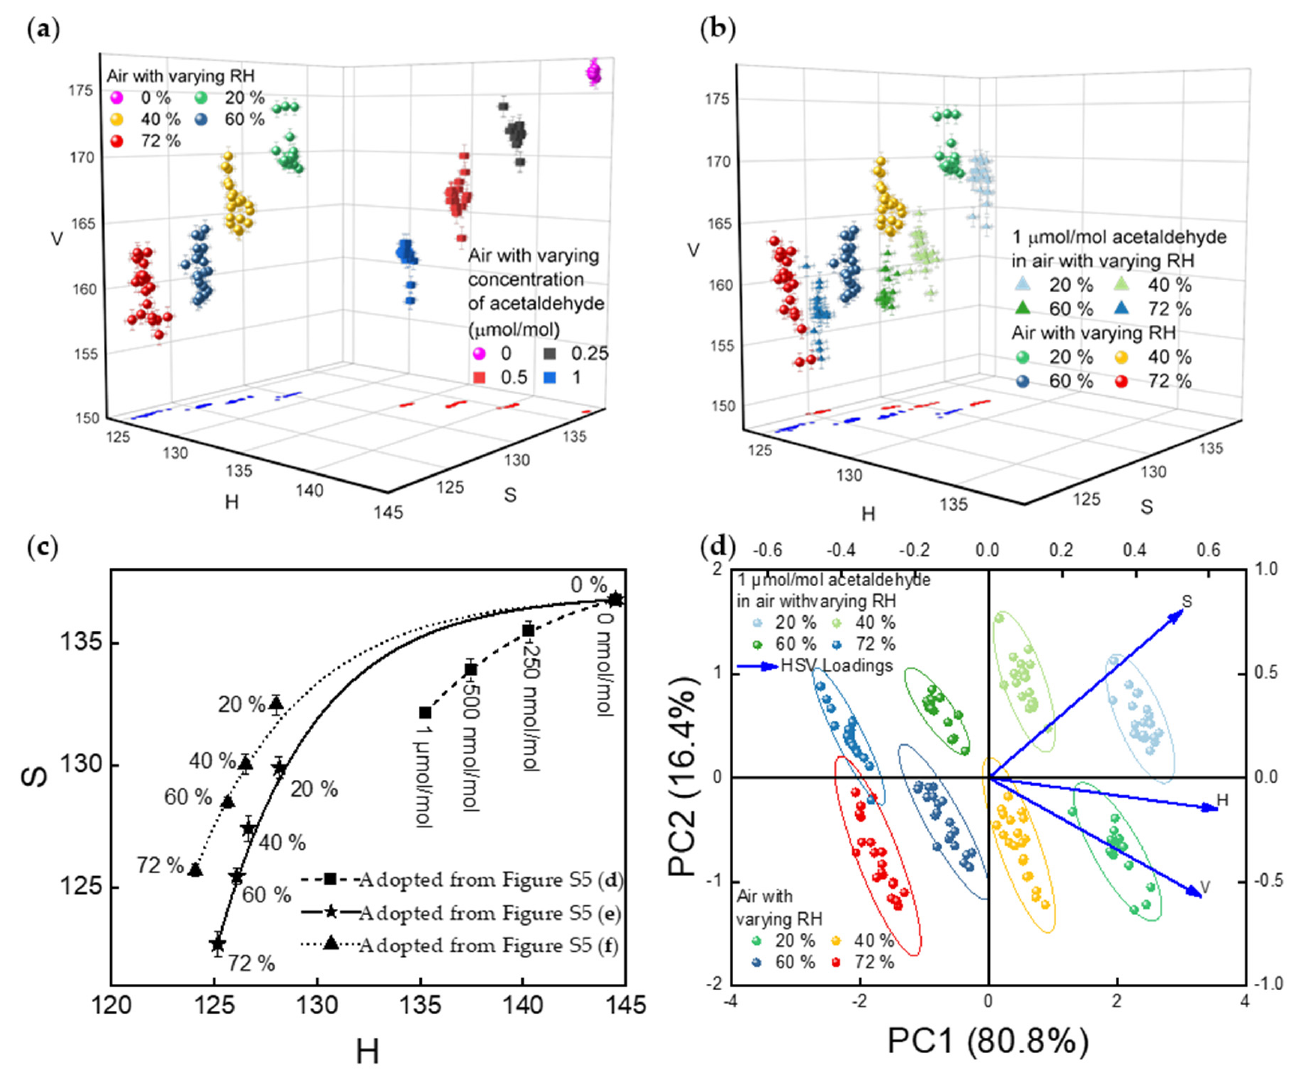
Figure 7. ( a ) Comparing NHA sensors’ responses to varying concentrations of acetaldehyde (0 to 1 µ mol/mol) and varying RH levels (0%, 20% 40%, 60%, and 72%). ( b ) Comparison of NHA sensors’ responses to varying RH levels with and without 1 µ mol/mol acetaldehyde. ( c ) Comparison of trend curves in Figure S5d–f. The error bars along the x -axis and y -axis represent ± 1 standard deviation of H and S for data collected from 4 different testing trials on 2 sensor chips, respectively. Please note that for relatively small error values, the data labels may obscure the error bars. ( d ) PCA result of NHA sensors’ responses to varying RH levels with and without 1 µ mol/mol acetaldehyde. The first 2 PCs account for 97.2% ( ≥ 95%) of the total variation. Ellipses that cover each dataset were generated with 95% confidence.